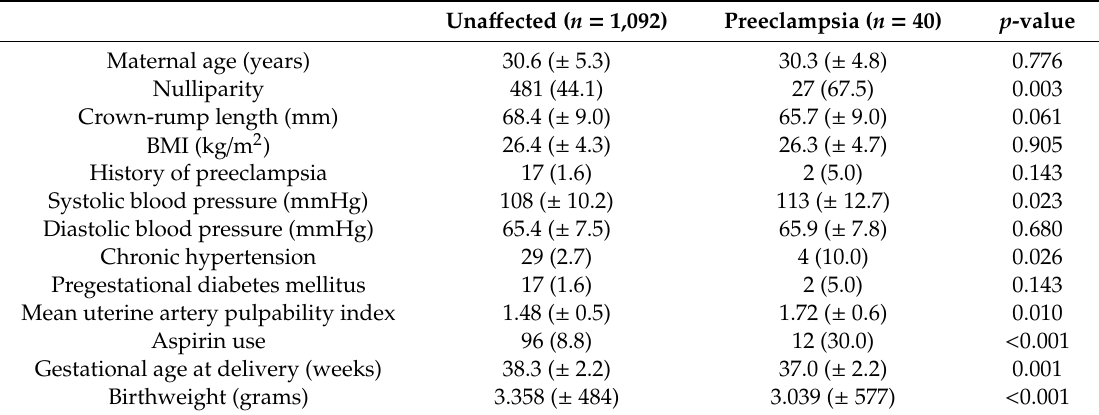
Table 1. Maternal baseline characteristics, medical and obstetric history, and pregnancy outcomes in una ff ected and preeclampsia